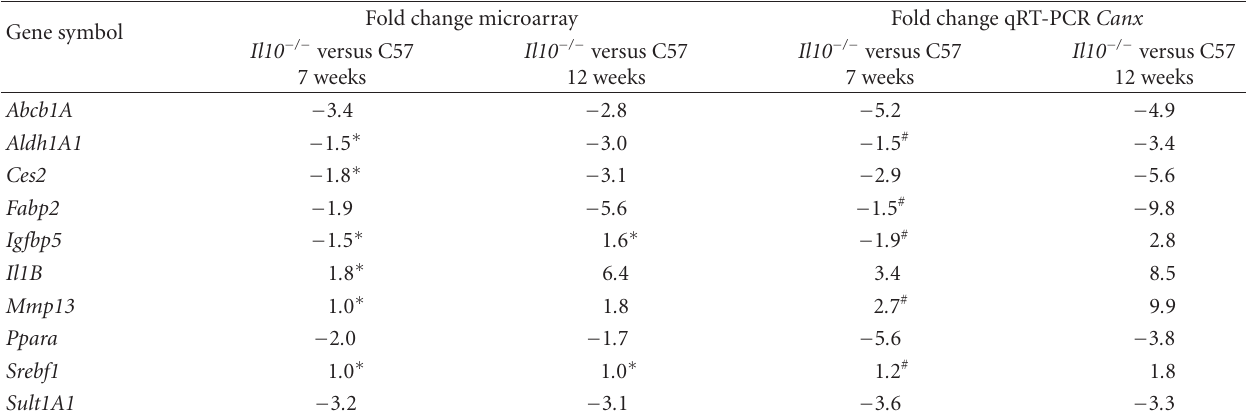
Table 3: Validation of gene expression results from microarray analysis using